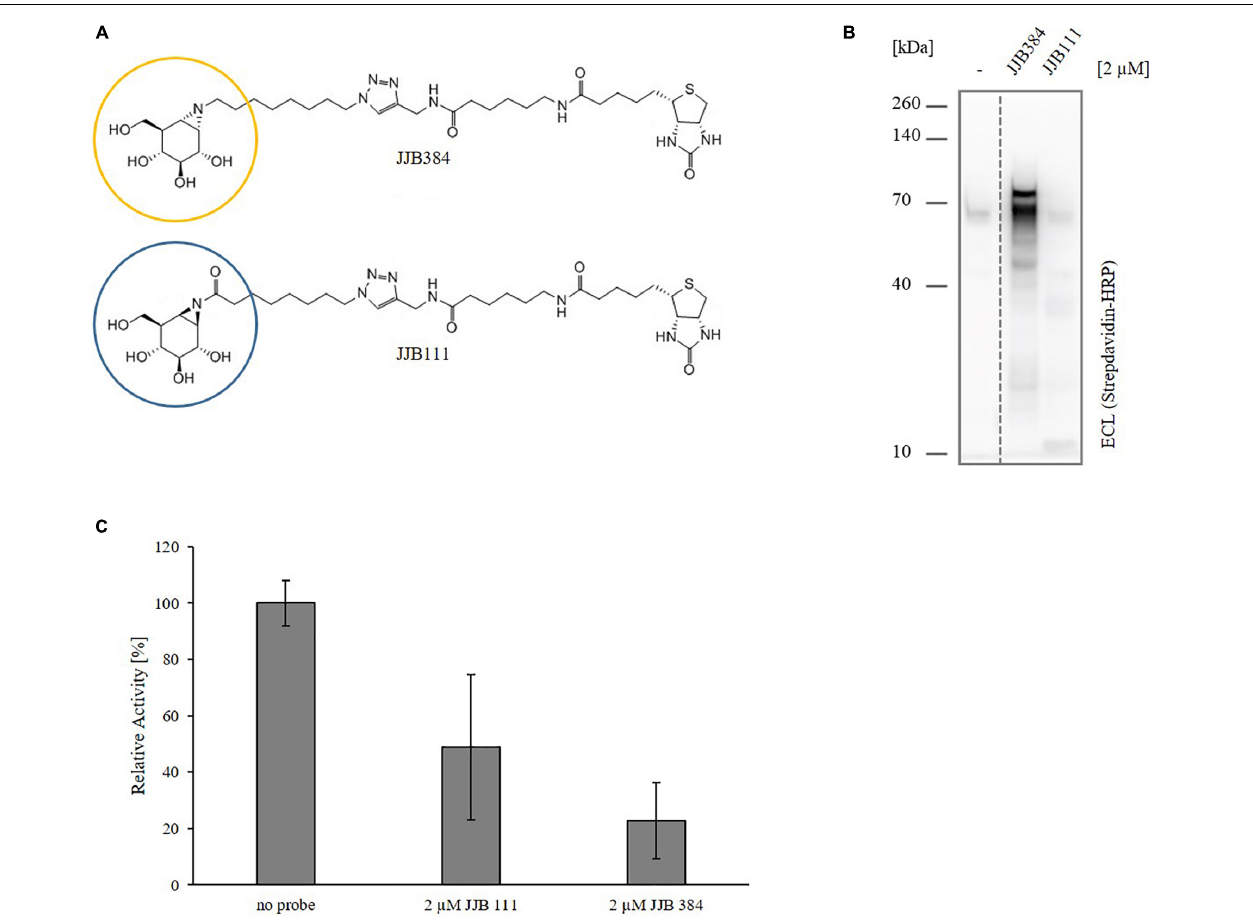
FIGURE 5 | ABPP of Thermococcus sp. strain 2319x1E with glycosidase-selective probes. (A) Chemical structure of the two employed glycosidase-selective ABPs JJB384 and JJB111. The circles indicate the cyclophellitol aziridine moieties (yellow, α -configured moiety of JJB384; blue, β -configured moiety of JJB111) which function as warheads covalently binding to the target proteins. (B) Western blot analysis of the in vivo profiled Thermococcus sp. strain 2319x1E proteome of cells grown on xylan after separation via Bis-Tris gel electrophoresis and detection with a streptavidine HRP conjugate. The cells were incubated with 2 µ M of either of the two ABPs or with DMSO as control for 2 h at 78 ◦ C with constant shaking. (C) Xylanolytic activity of Thermococcus sp. strain 2319x1E cell extracts (20 µ g protein) after incubation in presence or absence of 2 µ M of the respective probe for 2 h at 78 ◦ C. Inhibition of xylanolytic activity was determined in